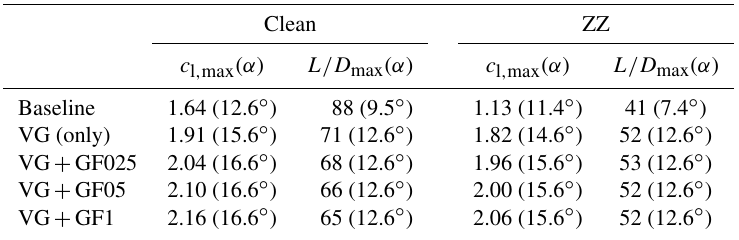
Figure 11. DU97W300. Vortex generators and Gurney flaps. (a) Lift and drag coefficients (clean). (b) L/D ratio (clean). (c) Lift and drag coefficients (ZZ). (d) L/D ratio (ZZ). Table 7. DU97W300. Vortex generators plus Gurney